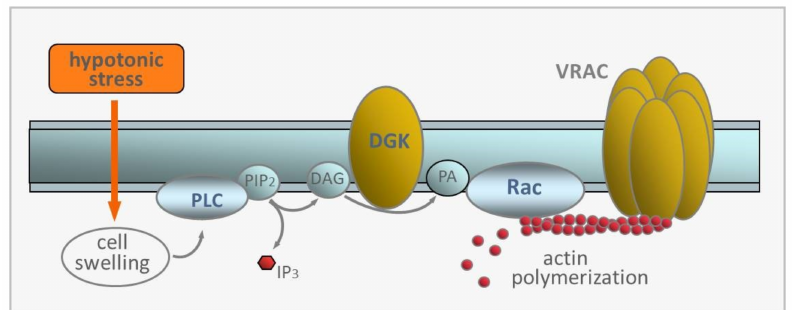
Figure 2. Hypothetical sequentially coupled transduction pathway leading to the activation of VRAC by hypotonicity-induced cell swelling. PLC, phospholipase C; PIP 2 , phosphatidylinositol bisphosphate; IP 3 , inositol trisphosphate; DAG, diacylglycerol; DGK, DAG kinase; PA, phosphatidic acid. Rac, small signaling G protein, member of Rho family of